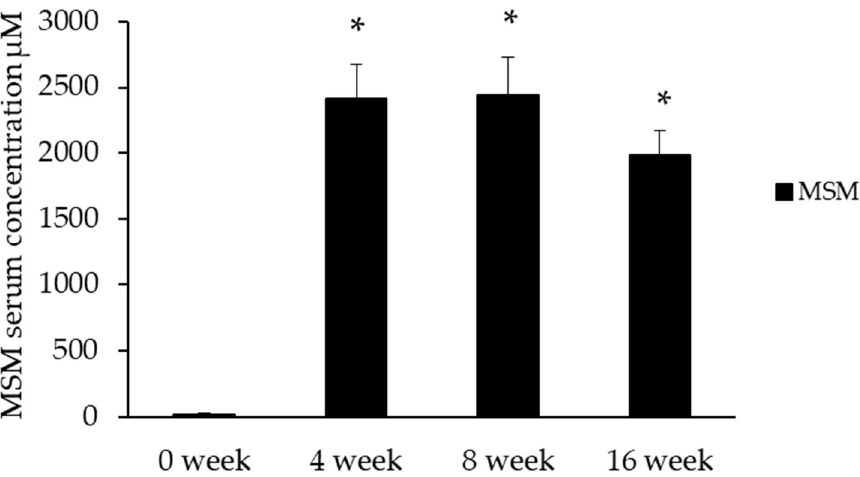
Figure 2. Serum MSM concentrations were significantly elevated after 4 weeks of supplementation in the MSM group. MSM was undetectable in serum samples from placebo at each time point. * Indicates significantly different from baseline, p ≤ 0.001.